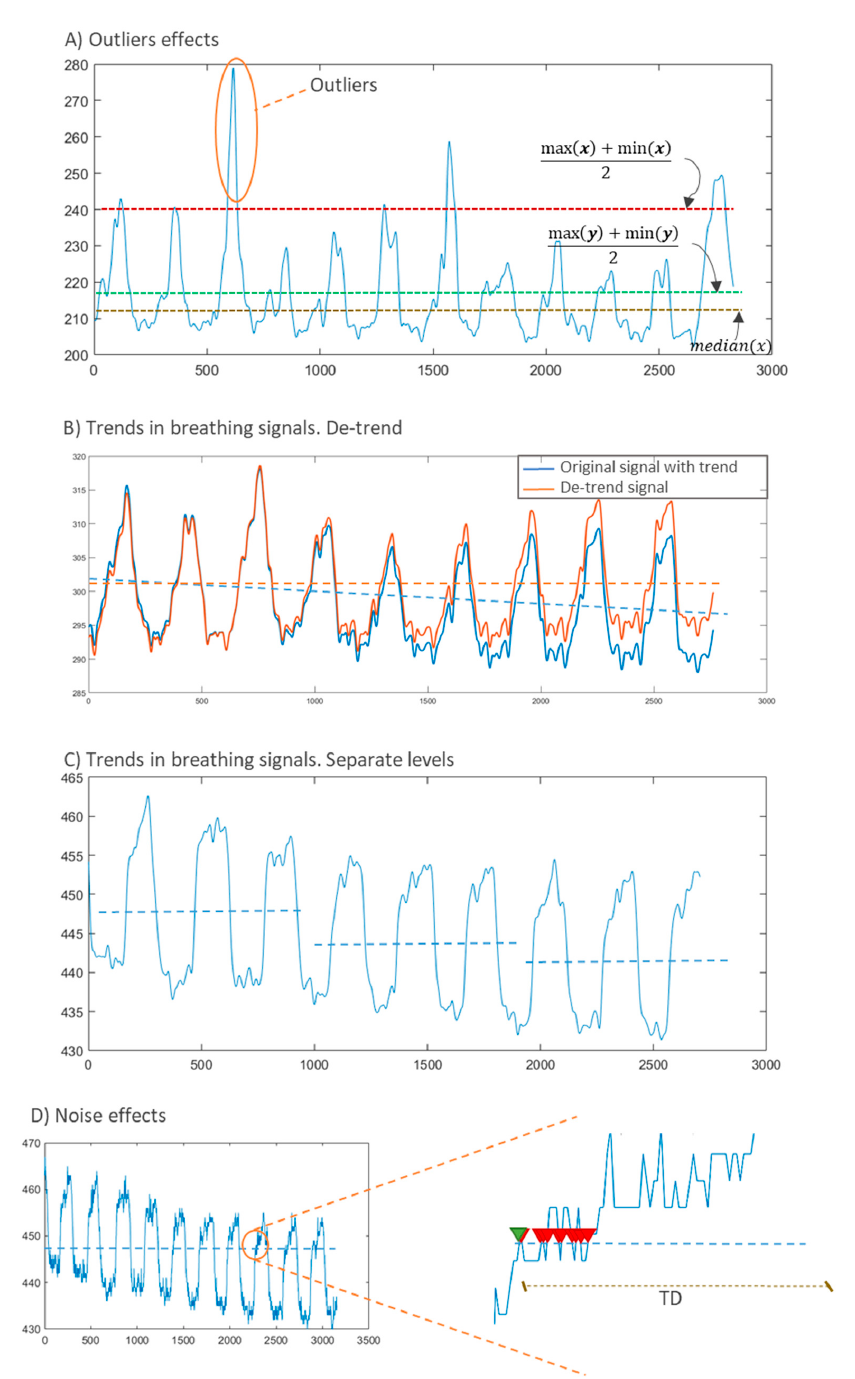
Figure 30. Zero-crossings method exemplified in a real signal obtain from the public breathing dataset of Vanegas et al. [254]. ( A ) E ff ect of the presence of outliers in the signals in the calculation of the “zero level”. ( B ) Example of a signal with trends and results of applying a de-trend processing. ( C ) Example of using di ff erent “zero levels” in a signal with trends. ( D ) Example of a noisy signal with several zero-crossings detected when only one of them (green) should have been